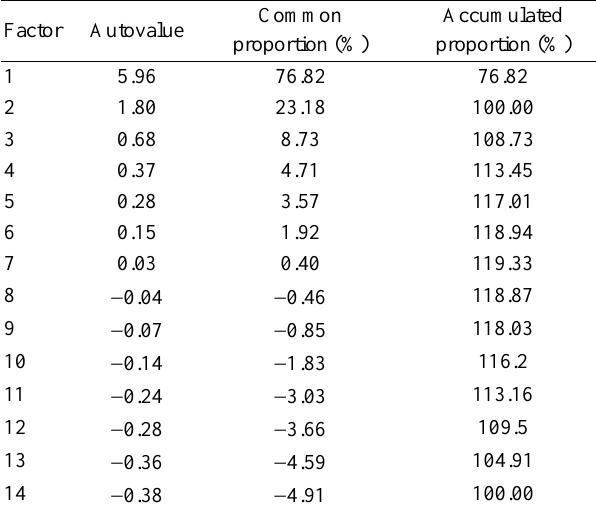
Table 3. Autovalues, common variance and accumulated